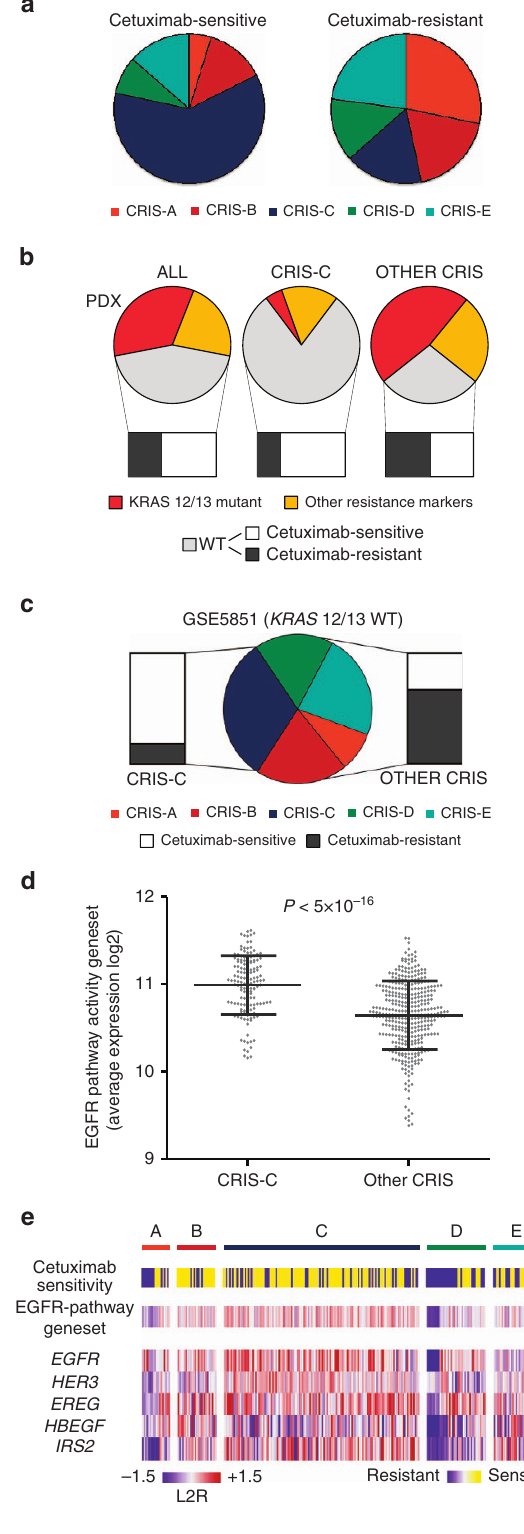
Figure 5 | CRIS-C and EGFR pathway activity predict cetuximab sensitivity. ( a ) Prevalence of CRIS classes among PDX cases scored as sensitive or resistant to cetuximab. ( b ) Bar-of-pie charts showing the distribution of validated resistance biomarkers ( KRAS mutations in codons 12 and 13) and proposed resistance biomarkers (other resistance markers; for their enumeration, see Supplementary Data 4) in PDXs (pies). The fraction of sensitive or resistant cases specifically in the PDX subpopulation that does not harbour resistance biomarkers is shown in the bars. The analysis encompasses the whole PDX data set, CRIS-C alone, and all other CRIS classes. ( c ) Bar-of-pie chart showing the distribution of CRIS subtypes in KRAS wild-type cases of GSE5851, a data set of CRC liver metastases annotated for clinical response to cetuximab monotherapy 37 (pie). Bars denote the fraction of tumours responsive or resistant to cetuximab within CRIS-C or in all other CRIS classes. ( d ) Average expression of the gene set indicative of EGFR pathway activity in samples assigned to CRIS-C versus samples assigned to all other CRIS classes; error bars represent s.d. from the mean; statistical significance was calculated by Wilcoxon rank-sum test. ( e ) Heatmap showing response to cetuximab, average expression of the gene set indicative of EGFR pathway activity, and expression of individual genes of the EGFR pathway activity gene set across CRIS classes. The analysis includes PDXs that do not harbour known genetic markers of